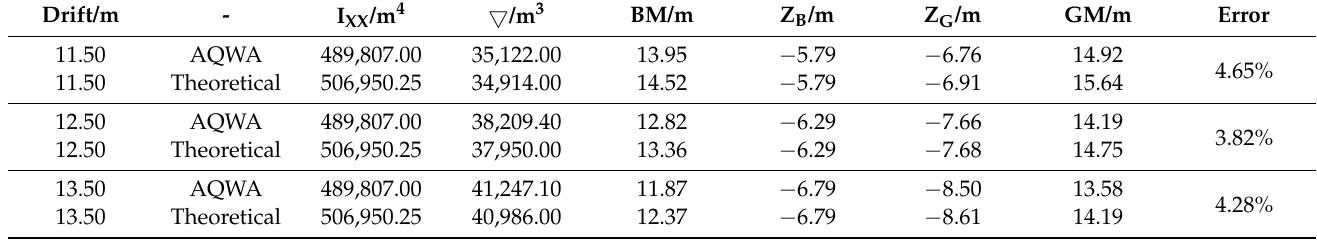
Table 3. Parameters calculated by theoretical method and numerical simulation.